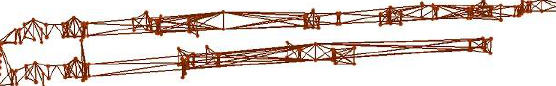
Figure 20. Navigable space (state and transition geometries) according to the walking locomotion (Person).